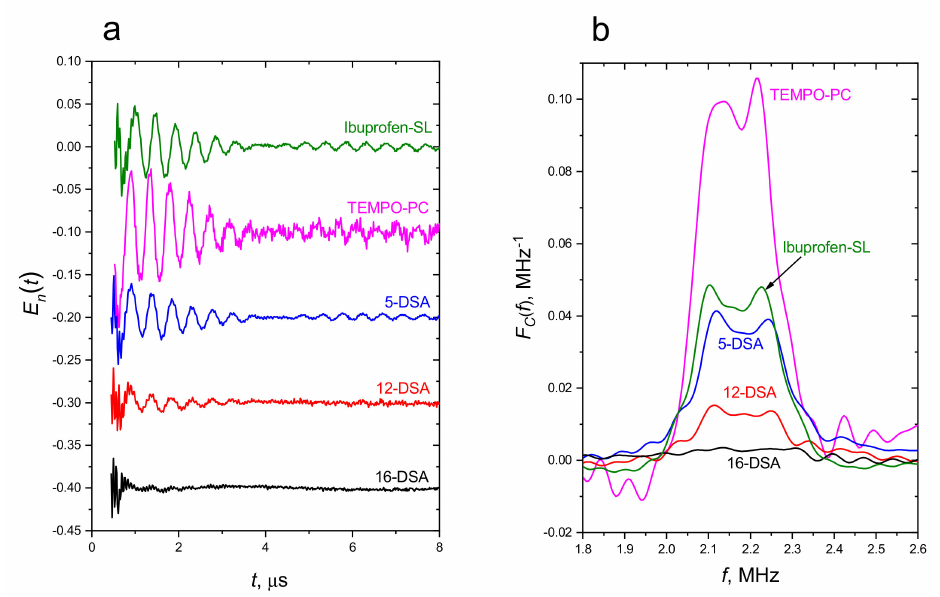
Figure 2. ( a ) ESEEM time traces for ibuprofen-SL in D 2 O-hydrated POPC bilayer. For comparison, the analogous data for TEMPO-PC (adapted from [49] under permission) and 5(12,16)-DSA are given. The data are vertically shifted for convenience. ( b ) Fourier transforms of the time domain